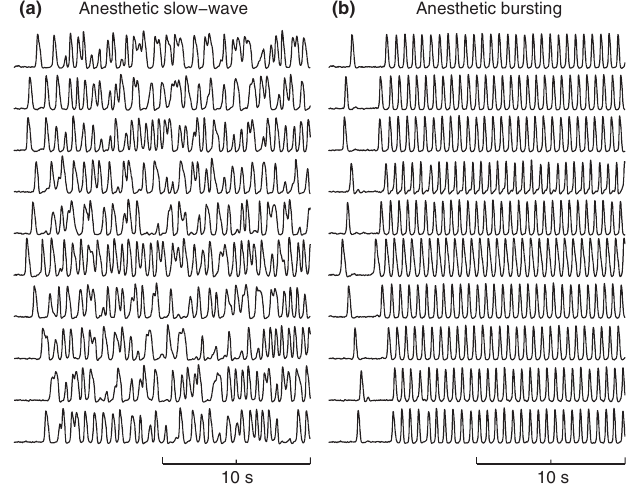
FIG. 10. Firing-rate time series for (a) chaotic anesthetic slow- wave oscillations ( D 2 ¼ 0 : 4 cm 2 ) and (b) bursting ( D 2 ¼ 0 : 3 cm 2 ) for 10 equally spaced points lying on the y ¼ 60 midline of the cortical grid. These graphs correspond, respec- tively, to horizontal samples x ¼ 1 þ 12 i ( i ¼ 0 ; . . . ; 9 ) within rows 4 and 5 of the strip-chart images of Fig.